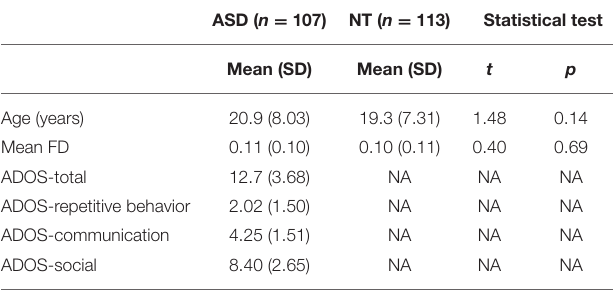
TABLE 1 | Demographic and clinical characteristics of the ABIDE-I